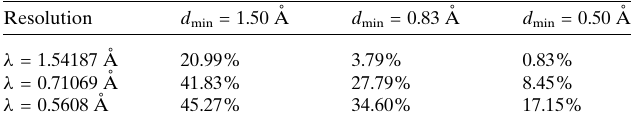
Table 1 Percentage of reciprocal space available in the HP experiment calculated analytically based on Equation (4), assuming a DAC double opening angle 2 (cid:2) of 70 (cid:2) .